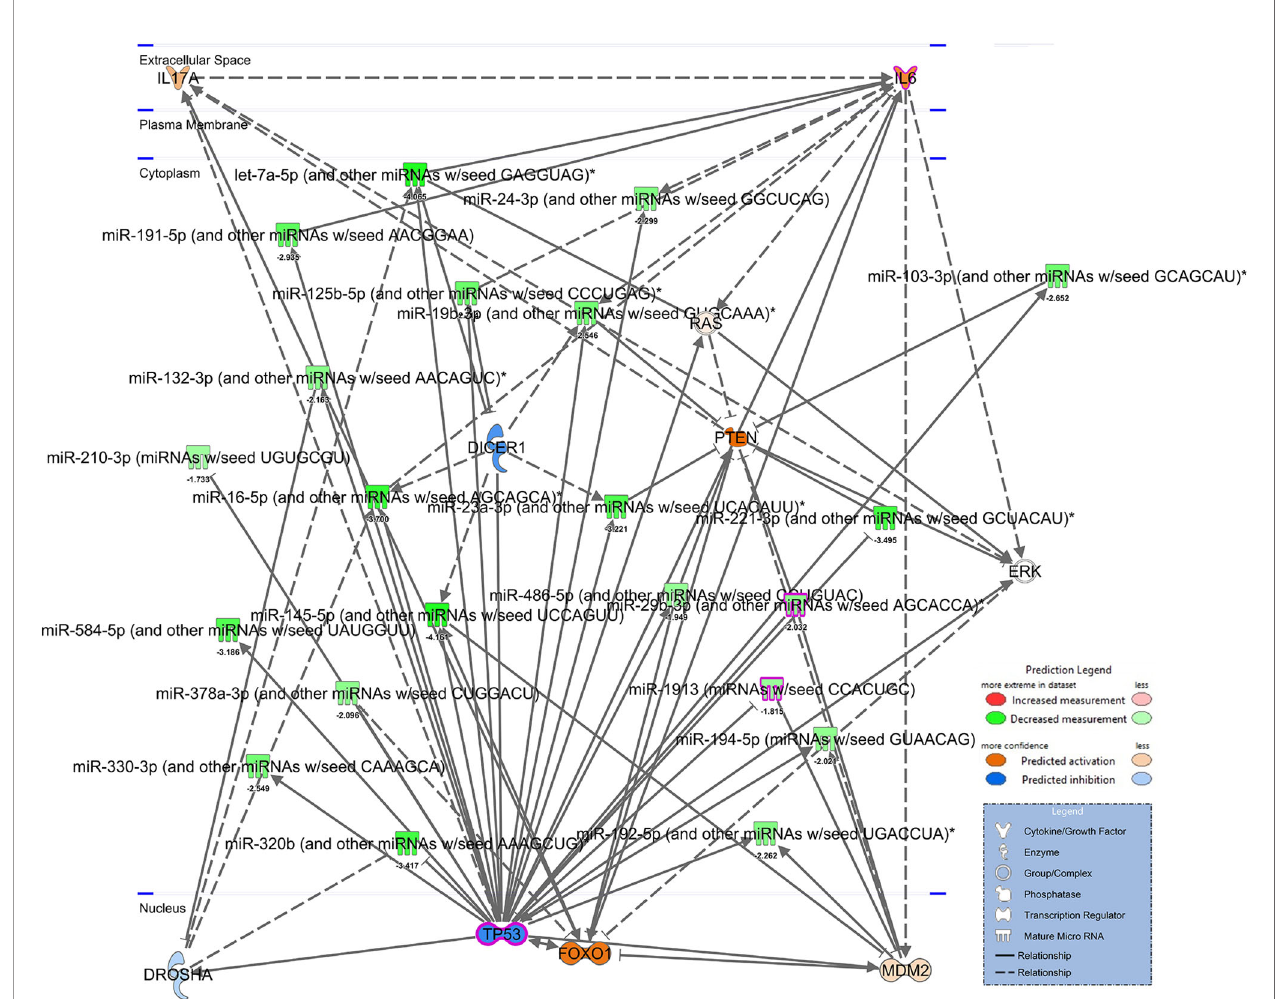
FIGURE 2 | Network of TP53 interactions with dysregulated miRNA from PTSD patients. IPA-derived network depicting dysregulated miRNA associated with TP53 from mean fold changes of Control (n=4) vs. PTSD (n=8) PMBCs. miRNA are depicted in green to denote downregulation (darker green denotes more downregulation) or red to denote decreased expression. Genes depicted in the network are predicted to be activated (orange) or inhibited (blue) based on interactions present, as noted in the Prediction Legend. A separate legend (lower right corner) is provided to identify components depicted in the network. Solid lines indicate direct interactions, and doted lines indicate either indirect or highly-predicted